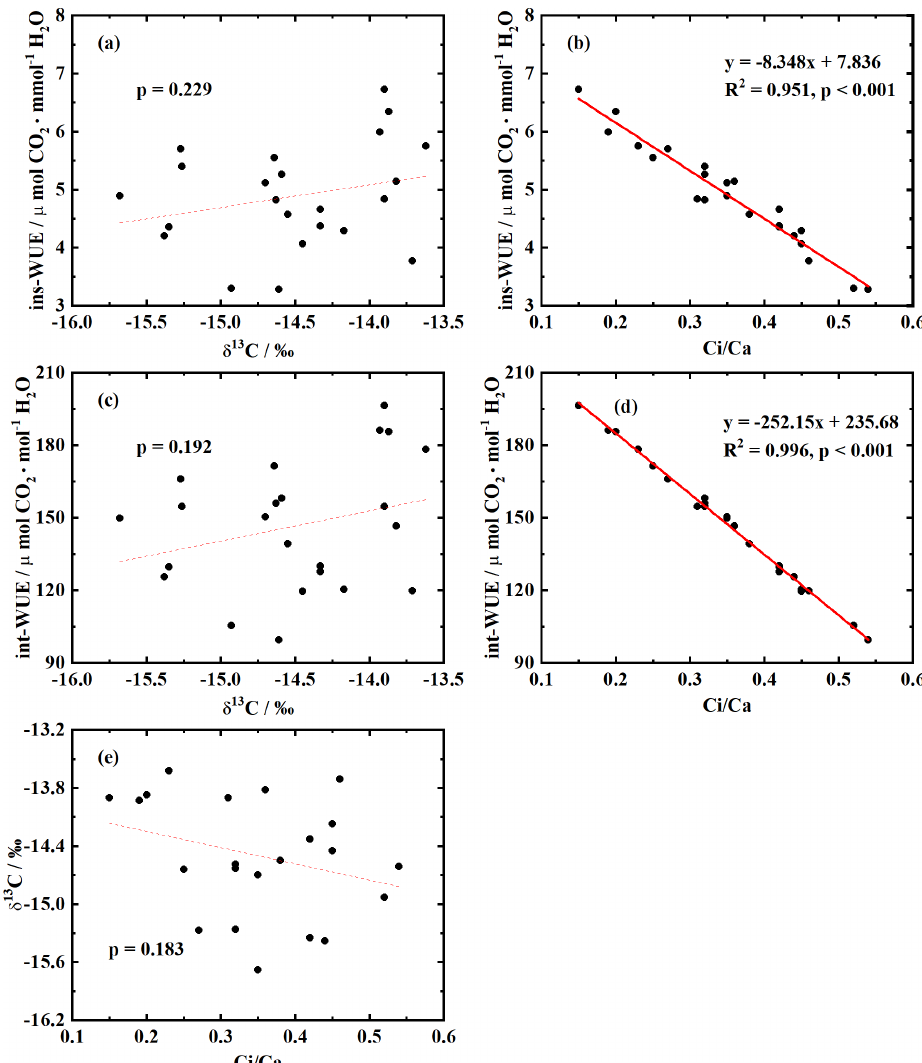
Figure 4. Correlations of ins-WUE vs. δ 13 C (a) , ins-WUE vs. c i /c a (b) , int-WUE vs. δ 13 C (c) , int-WUE vs. c i /c a (d) and δ 13 C vs. c i /c a (e) of assimilating branches of Haloxylon ammodendron